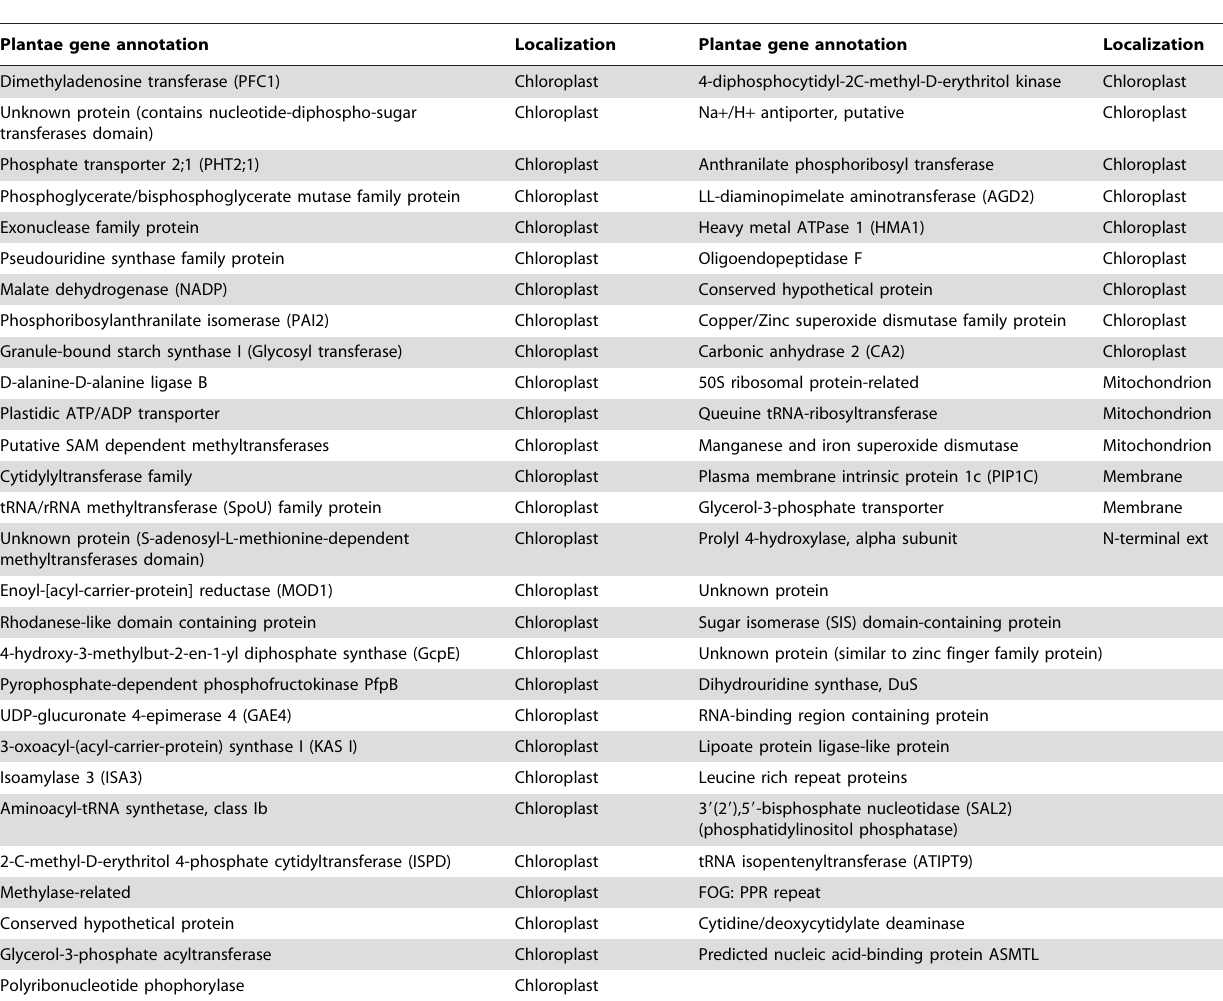
Table 1. The 55 nuclear genes of chlamydial origin that we found in genome data from 17 Plantae species, and the putative cellular localizations of the encoded proteins.